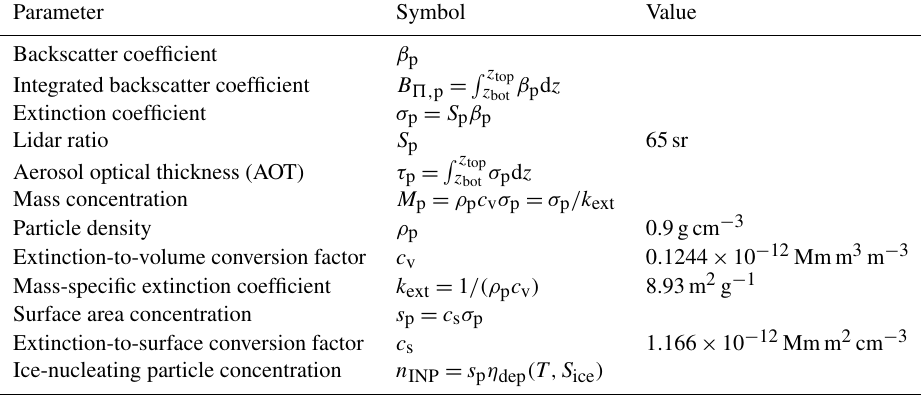
Table 1. Lidar-derived smoke (soot) particle optical and microphysical properties and retrieval input parameters for 532nm. z bot and z top are the layer base and top height of the detected stratospheric smoke layer, respectively. The values for the lidar ratio S p and the two conversion factors c v and c s are taken from Haarig et al. (2018), and the estimate of particle density ρ p is based on Rissler et al. (2013). For detailed explanations see